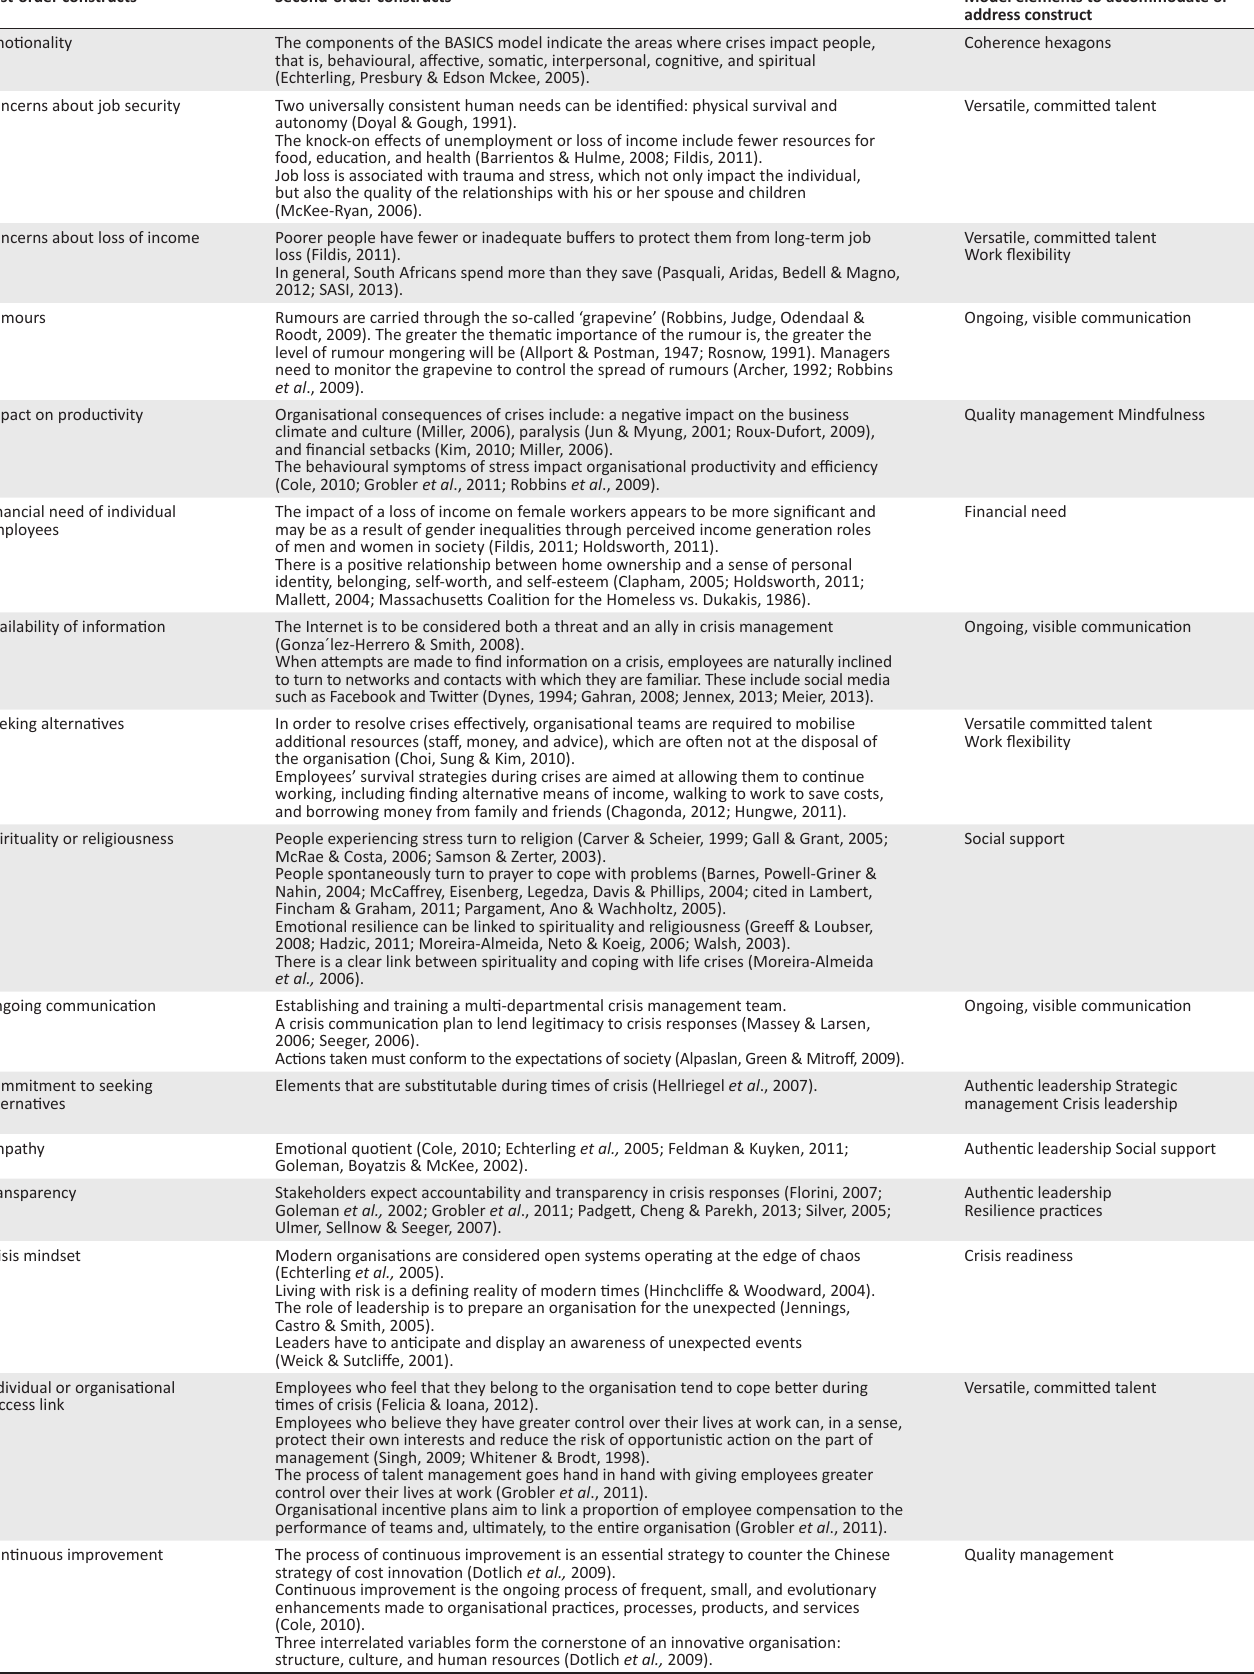
TABLE 3: Elements of the Coherence Hexagons